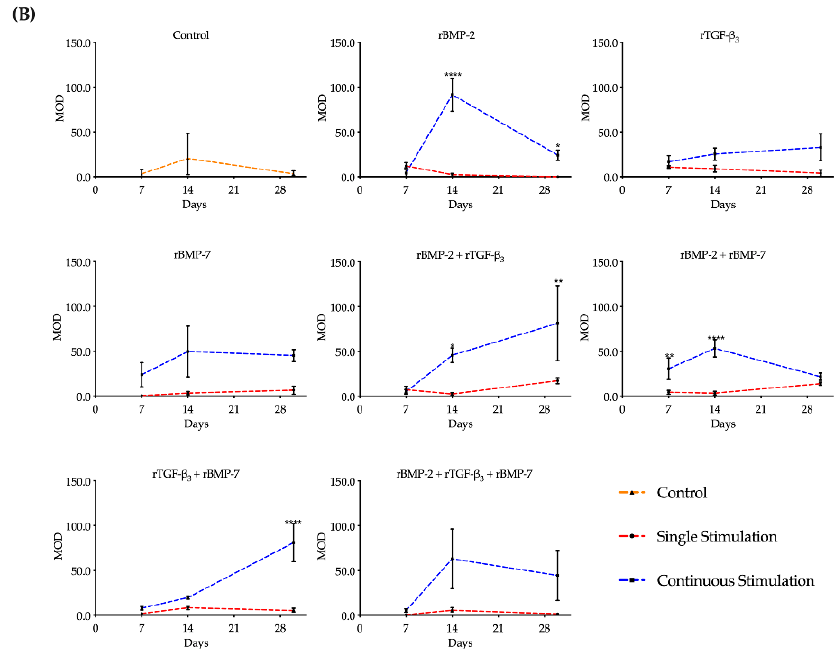
Figure 9. The semi-quantitative analysis results of immunohistochemistry. The results were presented as mean optical density value (MOD), which reflect the density of the antigen. The target antigen in immunohistochemistry was aggrecan. ( A ) Comparisons between each experimental group under di ff erent stimulation modes and the corresponding control group at day 7, 14 and 30 using one-way ANOVA. ( B ) Comparisons between the experimental groups where growth factors were applied continuously and the corresponding 48 h withdrawal groups at day 7, 14 and 30 using two-way ANOVA. Con. = control group, B = rBMP-2 treated group, T = rTGF- β 3 treated group, O = rBMP-7 treated group, B + T = rBMP-2 + rTGF- β 3 treated group, B + O = rBMP-2 + rBMP-7 treated group, T + O = rTGF- β 3 + rBMP-7 treated group, B + T + O = rBMP-2 + rTGF- β 3 + rBMP-7 treated group. Number of replicates ( n ) = 6. We defined p < 0.05 as a statistically significant di ff erence. * p < 0.05, ** p < 0.01, *** p < 0.001, **** p < 0.0001. In ( A ) statistical significance is expressed between each group and the control group (normal medium), while in ( B ) it is expressed in each time point between continuous stimulation and single